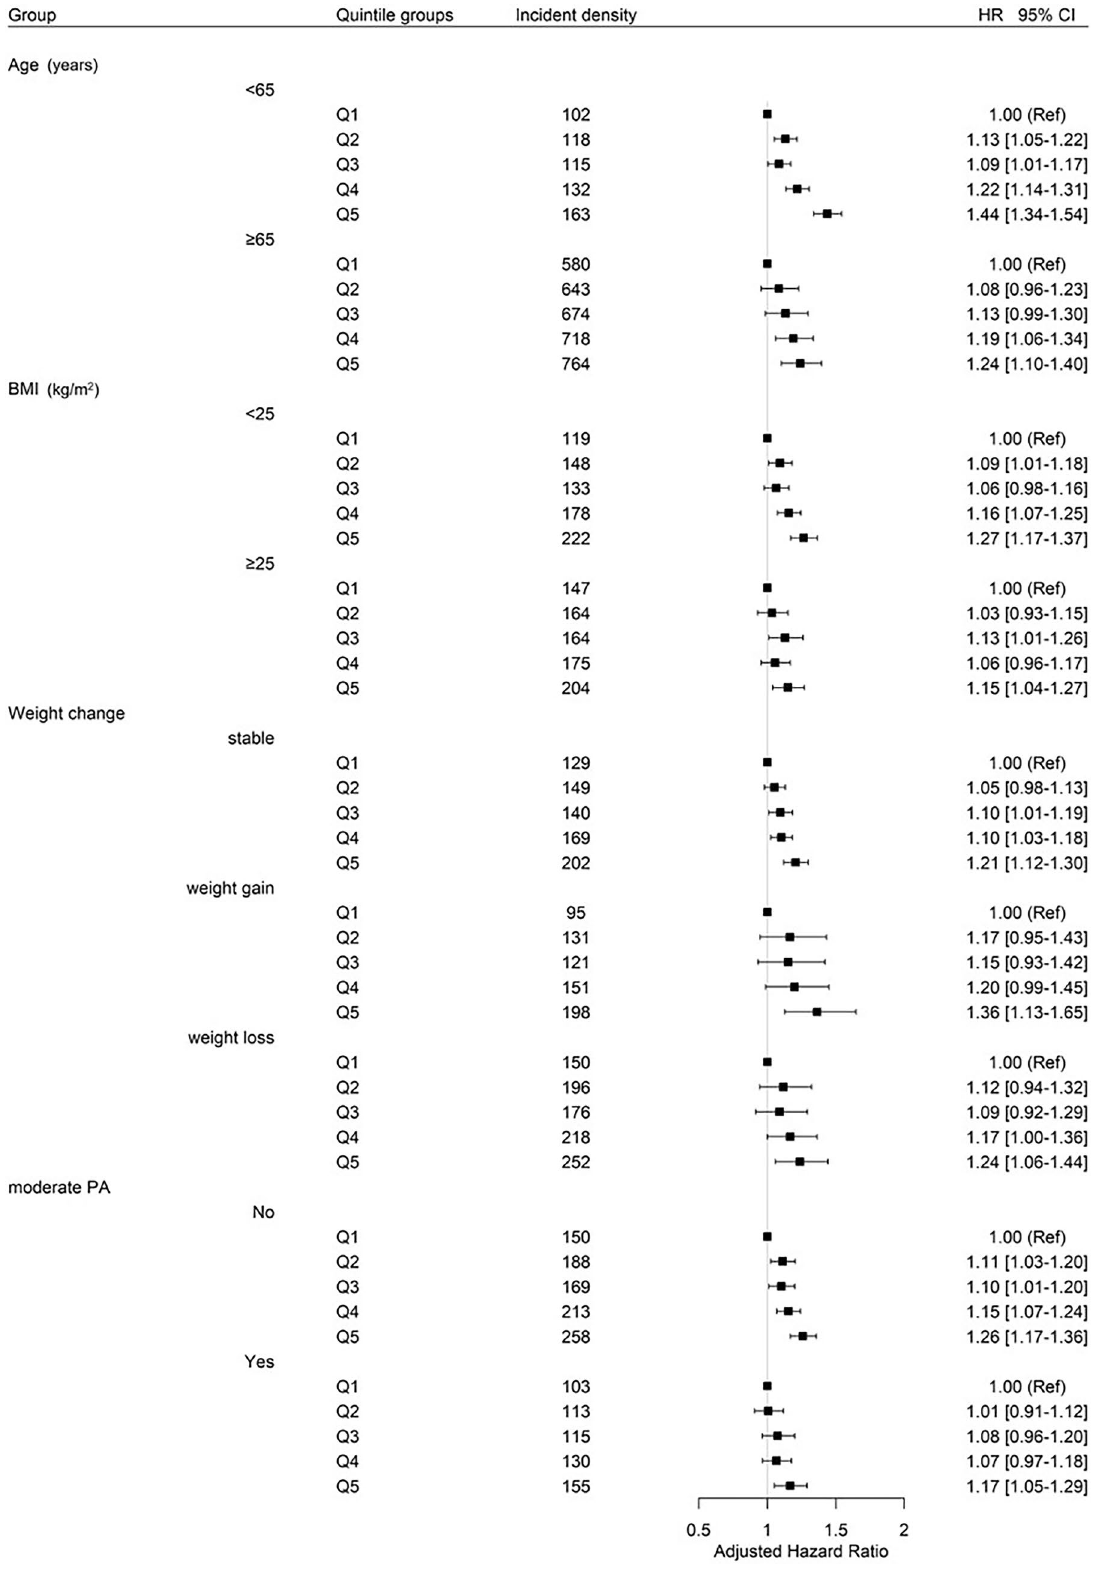
Figure 1. Stratified analyses of the effect of body weight variability on all cancers according to subgroups of age, initial body mass index, weight change and physical